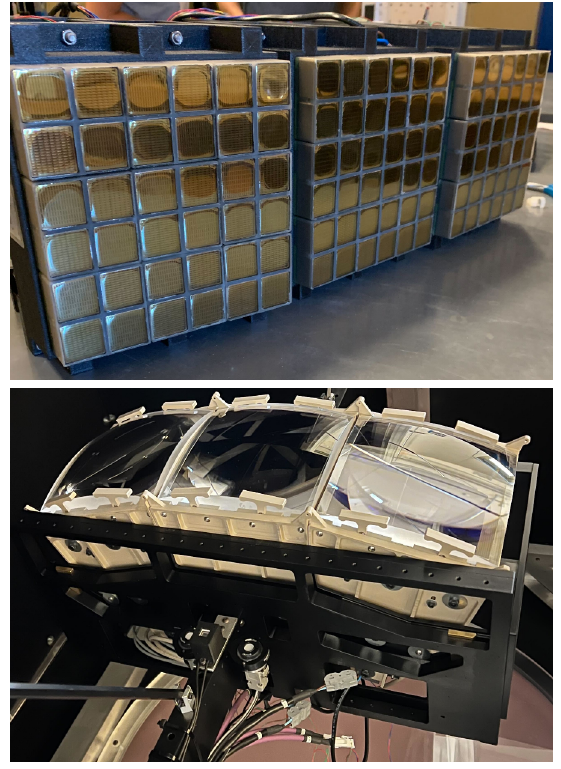
Figure 3: The FT camera: Top panel shows the 3 PDMs with a total of 6,912 pixels, the bottom panel shows the PDMs mounted in the telescope with the BG3 filter and field flattener in front of the MAPMTs.